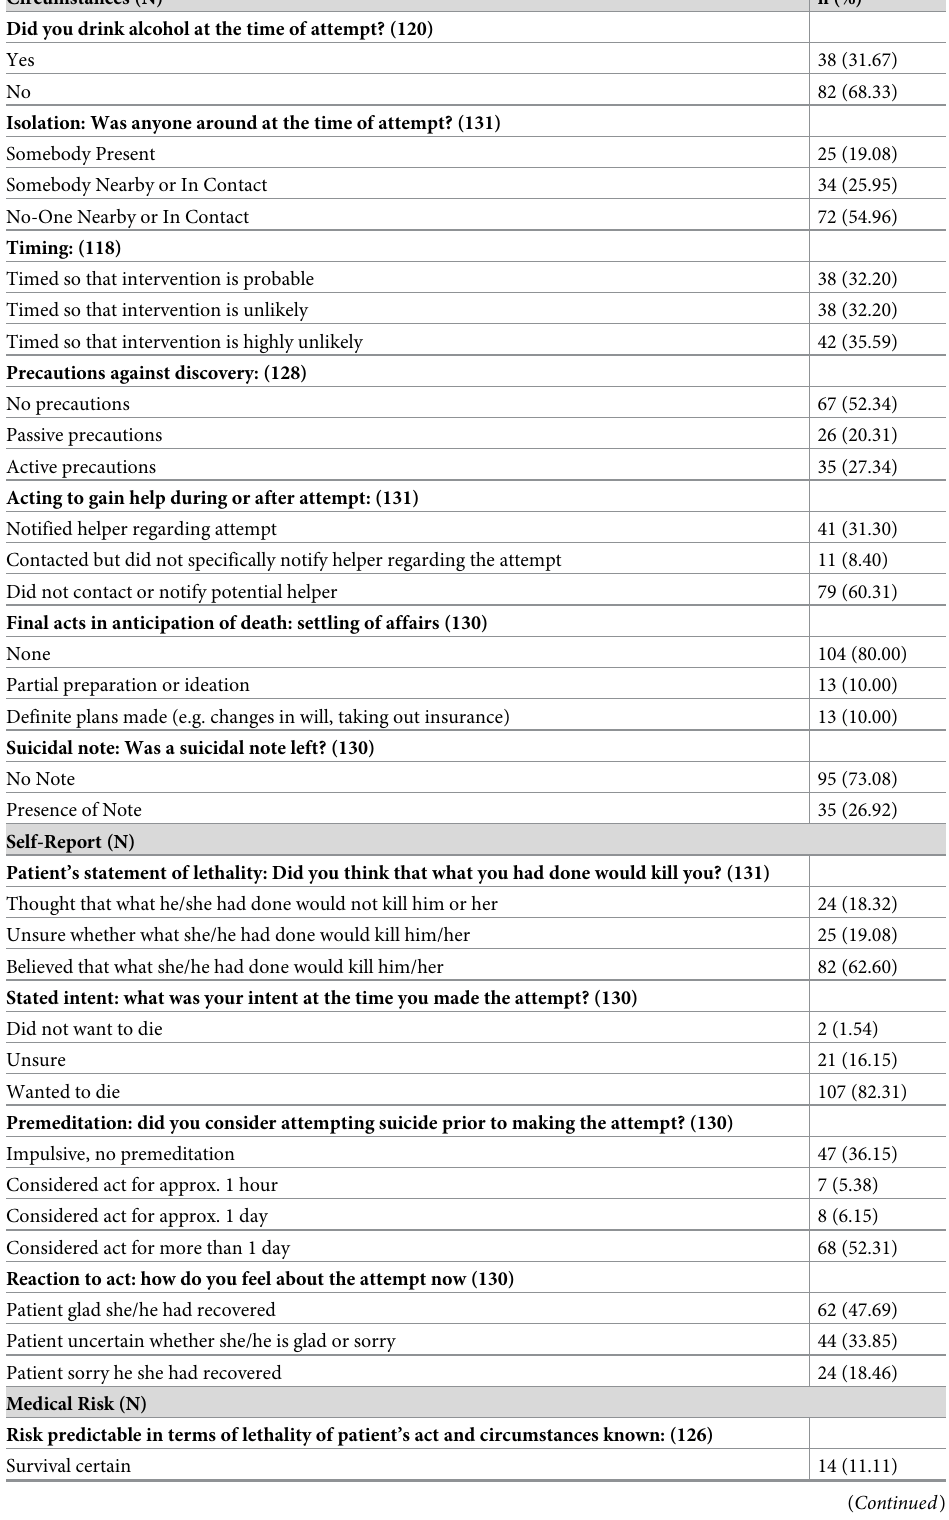
Table 4. Suicide intent scale questionnaire in case